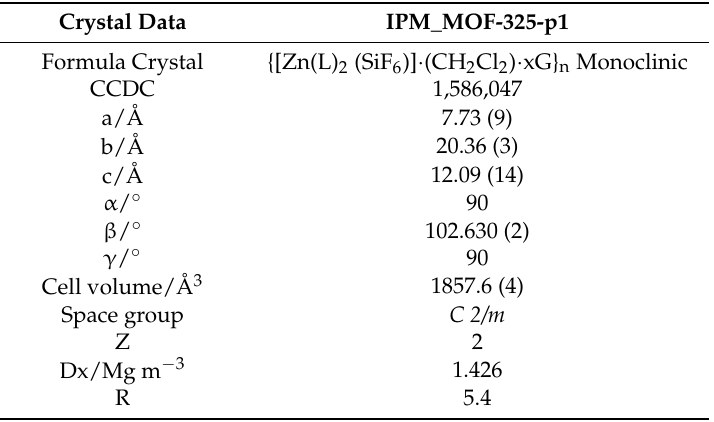
Table 1. Crystal data for